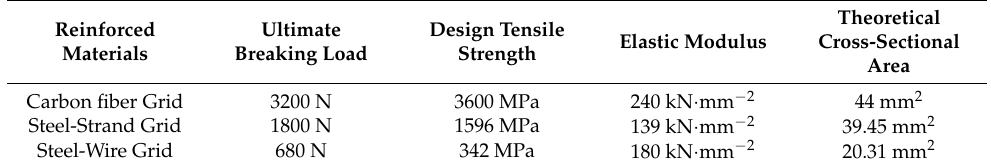
Figure 2. Reinforced materials. Table 4. Technical parameters of reinforced materials. Table 4. Technical parameters of reinforced